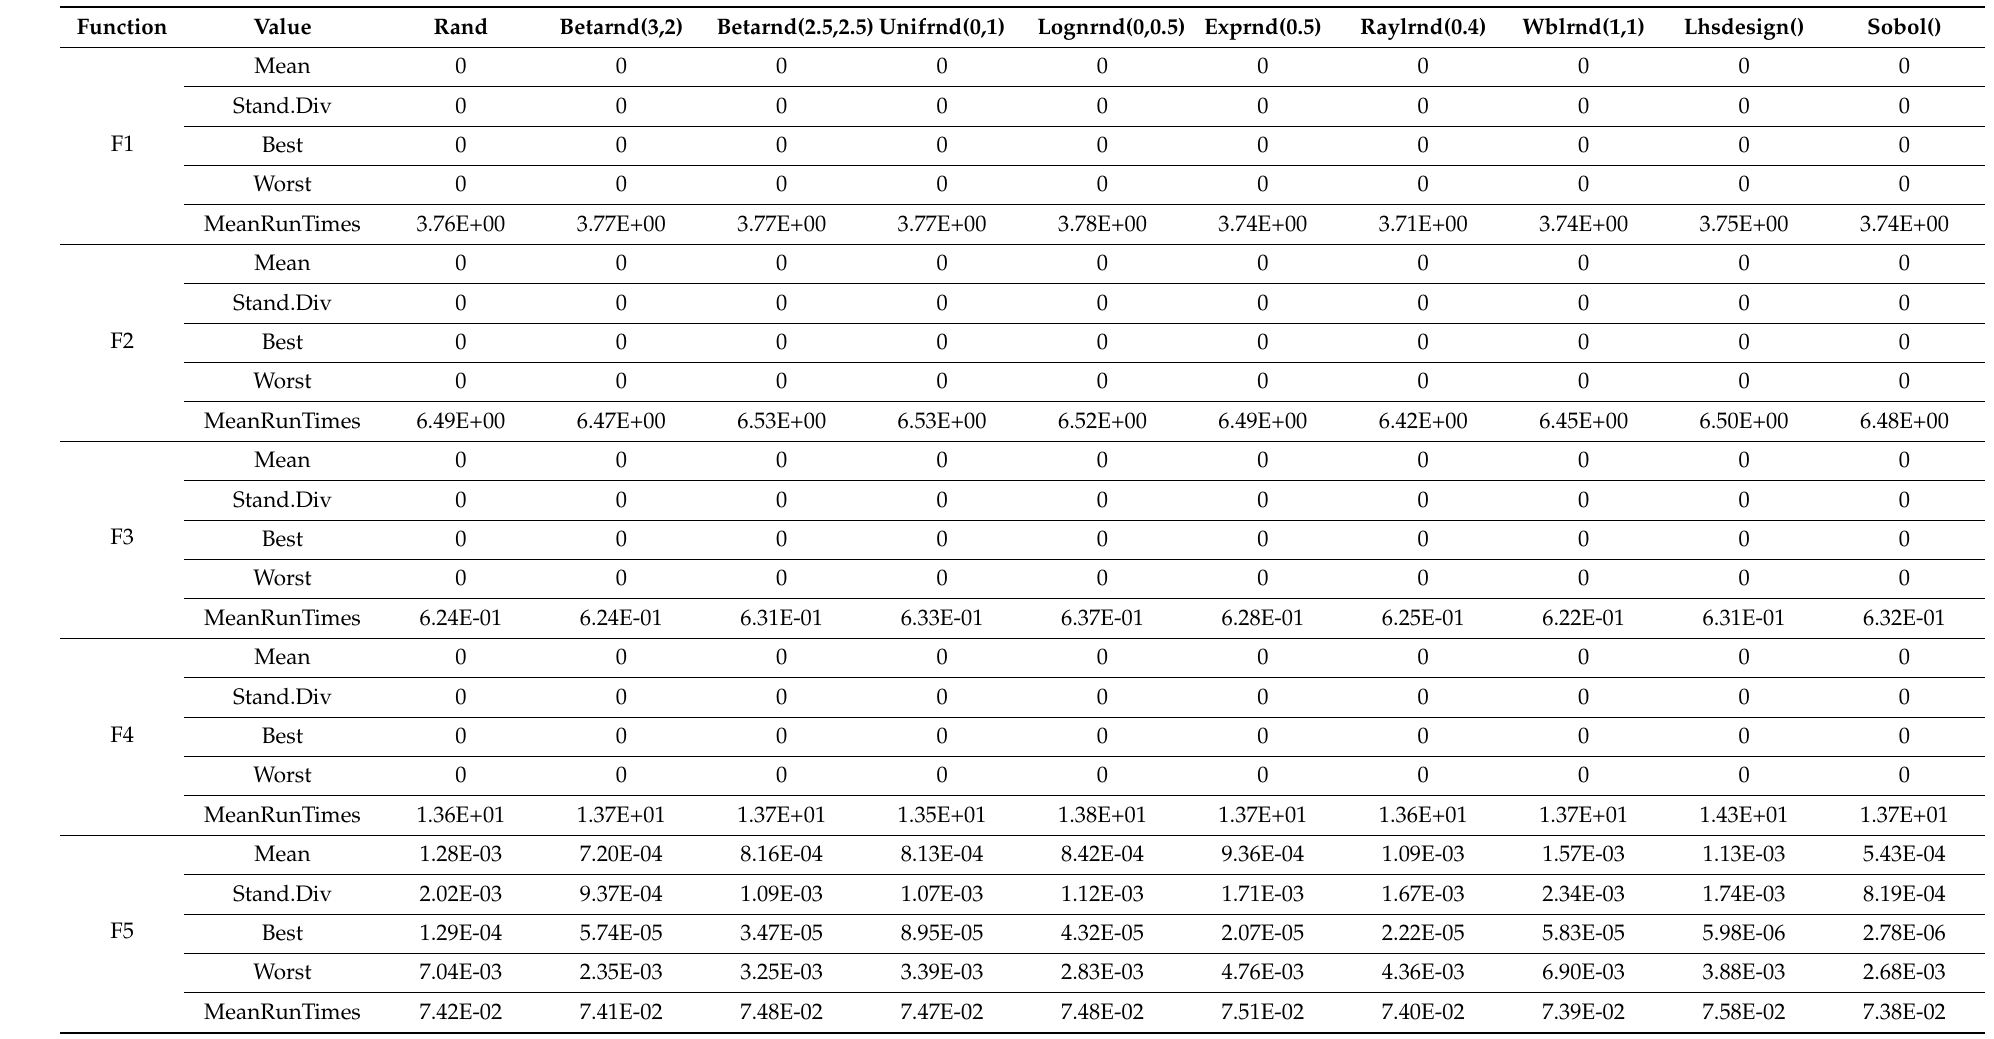
Table 19. Results for